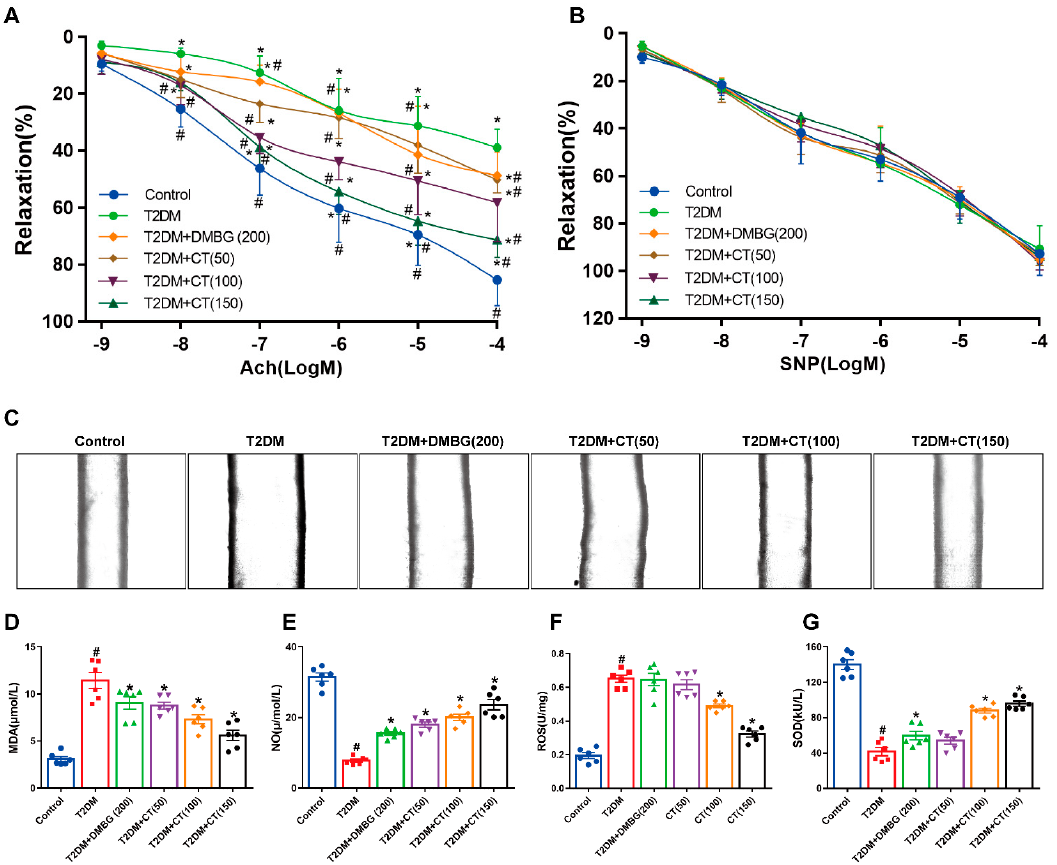
Figure 2. CT mitigated the dysfunction and oxidative stress of endothelial in T2DM rats. ( A ) Endo- thelium − dependent relaxation induced by acetylcholine (ACh) in the aortas. ( B ) Endothelium − in- dependent relaxation induced by sodium nitroprusside (SNP) in the aortas. ( C ) Mesenteric artery diastolic function was detected by in vitro microvascular tension measurement system. ( D − G ) The levels of MDA, NO, ROS, and SOD in carotid arteries were examined (N = 6). Data were analyzed by one-way ANOVA by Tukey post hoc tests or Bonferroni post hoc analyses. All data were ex- pressed as mean ± SEM. # p < 0.05 vs. Control group, * p < 0.05 vs. T2DM